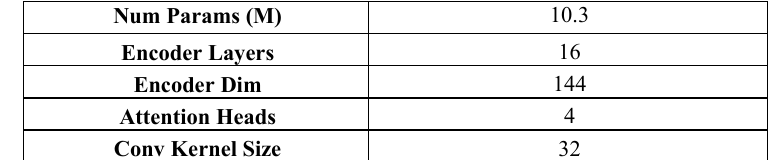
Table 2. The model hyper-parameters of Back-end.